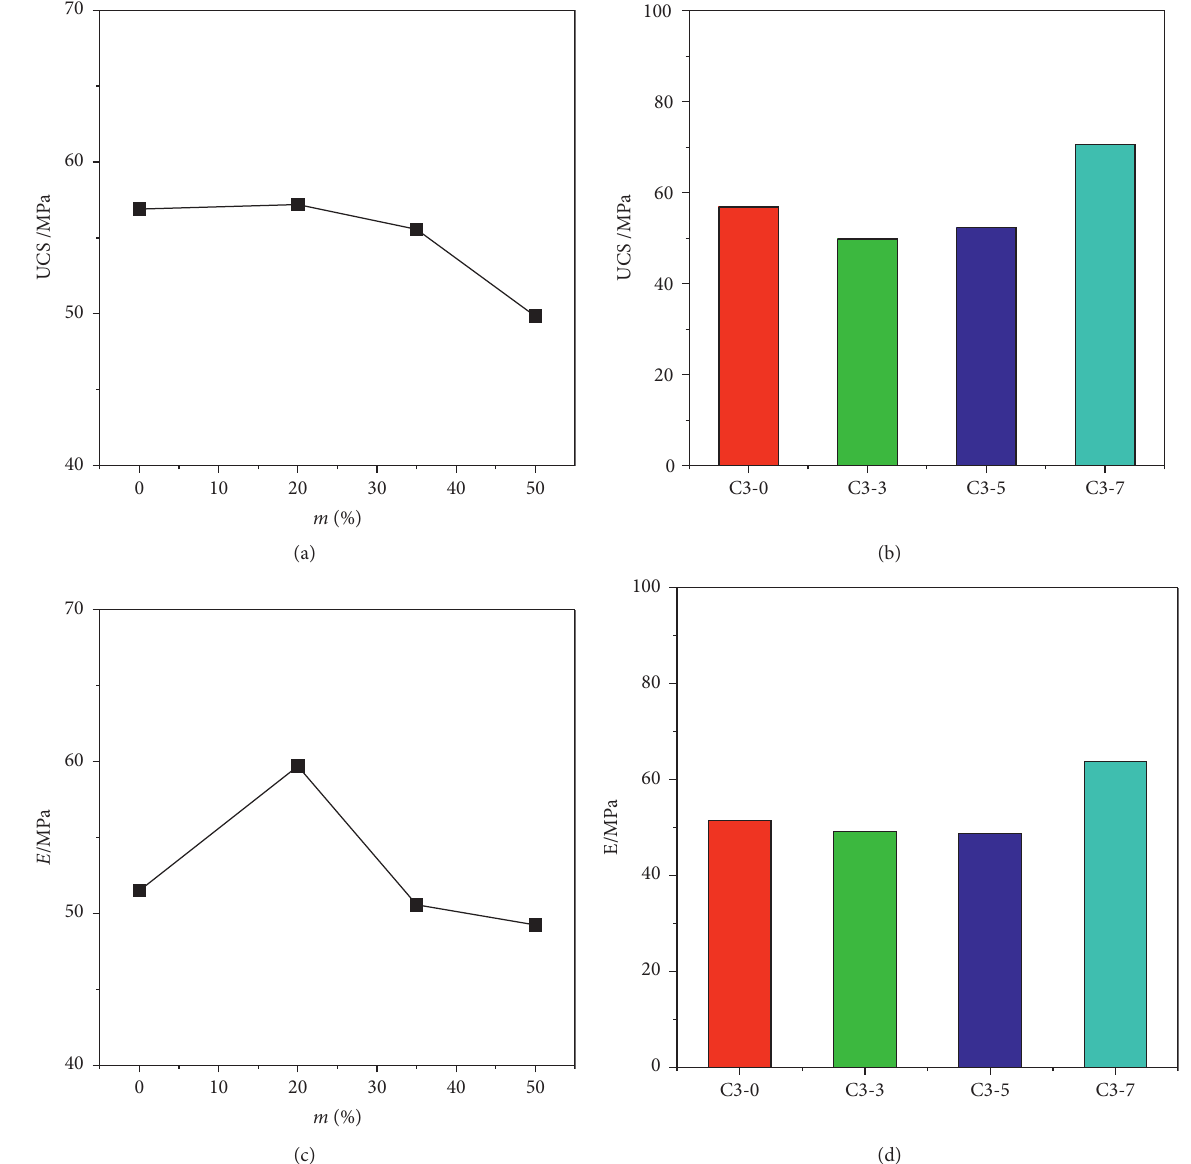
Figure 3: The variation of uniaxial compressive strength and elasticity modulus with (a, c) different fly ash contents and (b, d) admixture type of the concrete (without corrosion and freezing-thawing